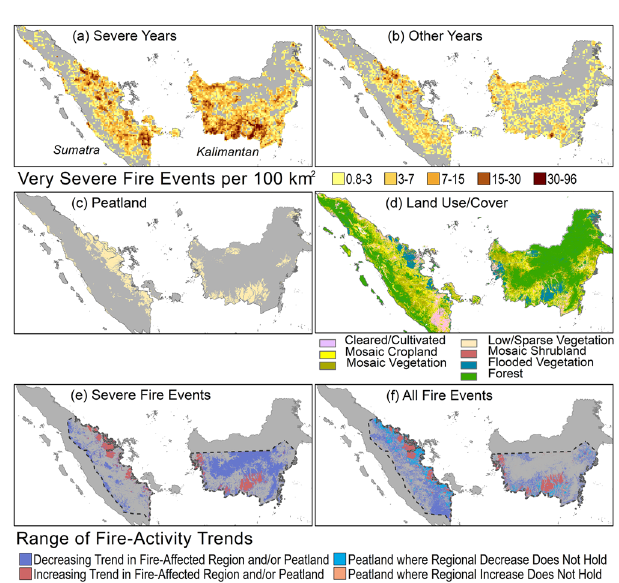
Fig. 2 Density of very severe fi re events in Sumatra and Kalimantan for years of severe fi re activity during 2002 – 2019 and all other years of 2002 – 2019, relative to Peatland and land-use/cover classes as of 2015, as well as the geographic ranges of signi fi cantly decreasing and increasing trends amongst severe fi re events and all fi re events over 2002 – 2019 for South-Central Sumatra, Southern Kalimantan, and Peatland therein separately. Years of severe fi re activity in a are those for which ≥ 25% of fi re events are severe, i.e., 2002, 2003, 2004, 2006, 2009, 2013, 2014, 2015, and 2019. See Supplementary Fig. 6 for a time-series version of a . d Classes are adapted from the Copernicus Climate Change Initiative Land-Cover Product 100, 101 (Table 1). e , f Signi fi cant trends are as per Table 2a, c, signifying the increasing/decreasing incidence of a given land use/cover amongst severe fi re events or all fi re events over 2002 – 2019, respectively. Dark coloured areas denote land-use/covers with signi fi cant increasing/decreasing trends in a fi re-affected region and/or in Peatland therein. A land use/cover is shaded separately inside and outside of Peatland accordingly. Land use/covers with increasing/decreasing trends across a given region but not across Peatland therein are shaded lightly within Peatland and are exclusive to f . Supplementary Fig. 13 repeats a through d for other areas of